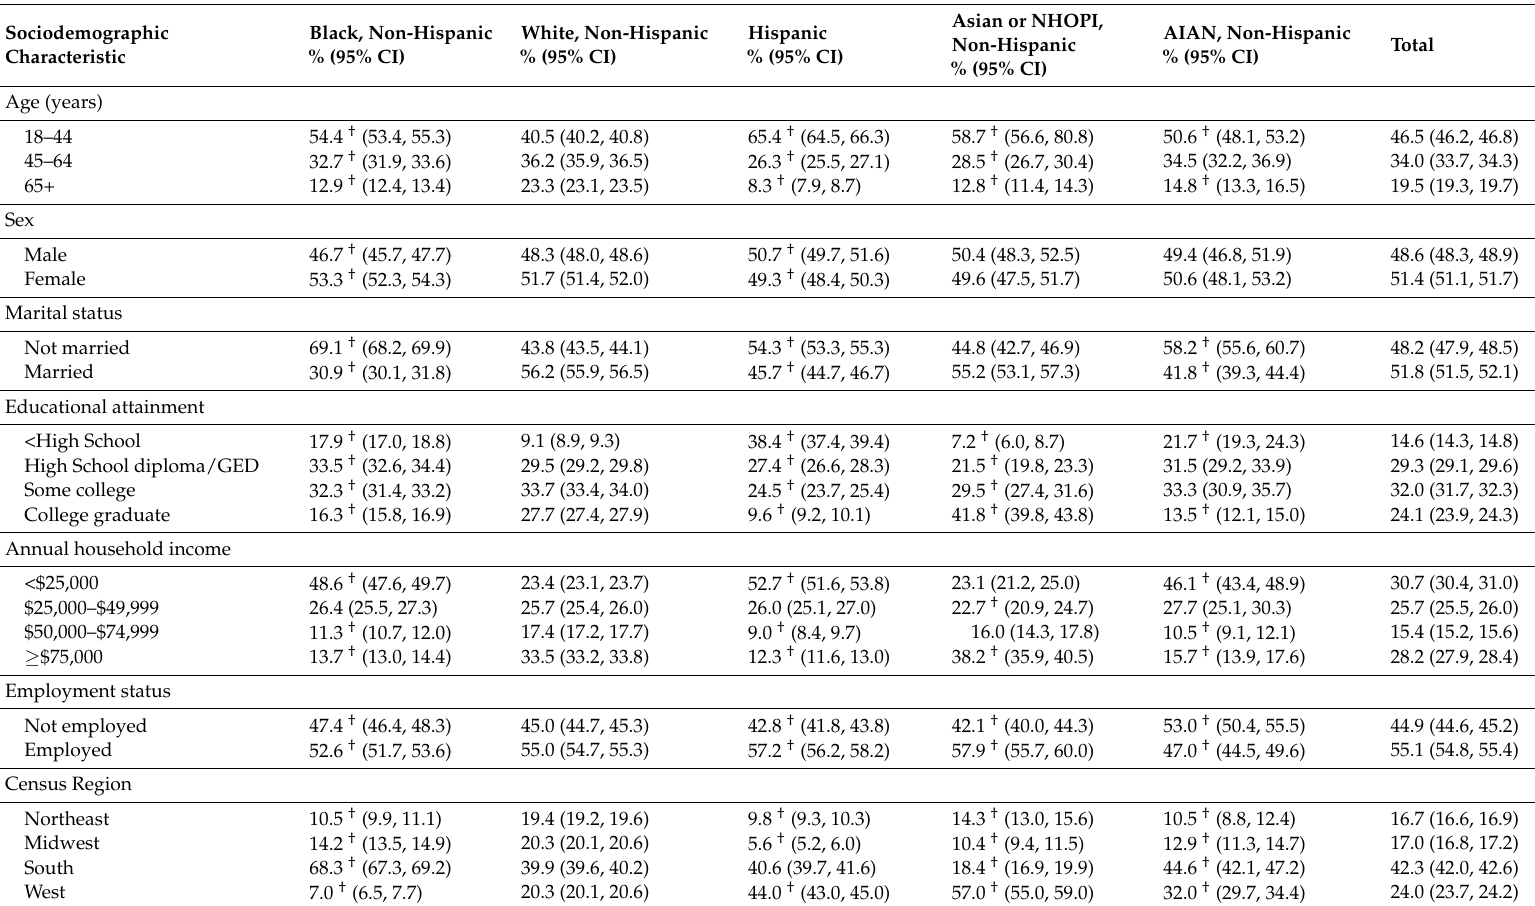
Table 4. Sociodemographic characteristics of medium metropolitan dwelling adults * by race and ethnicity: Behavioral Risk Factor Surveillance System, United States,